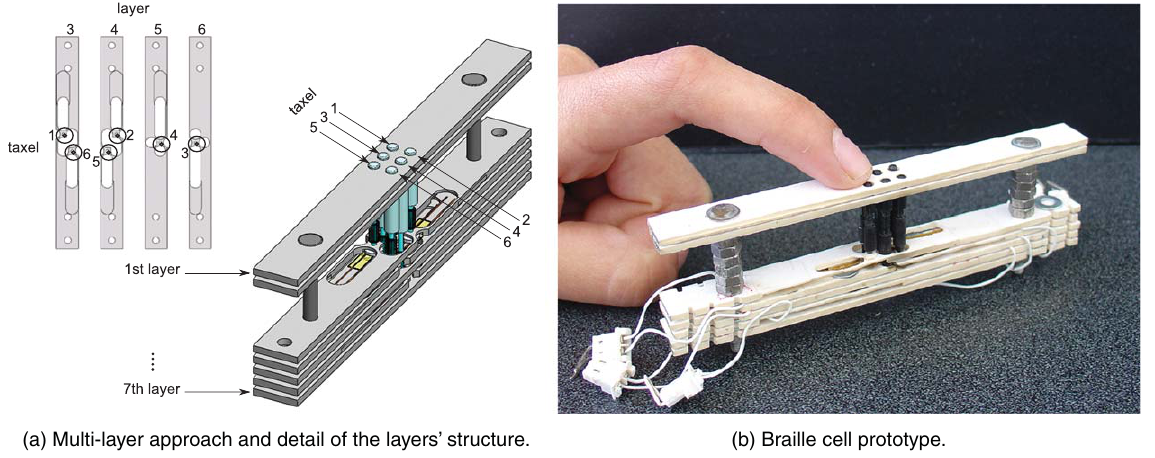
Fig. 12. Design and implementation of a Braille cell with piezoelectric ultrasonic linear motors and a multi-layer